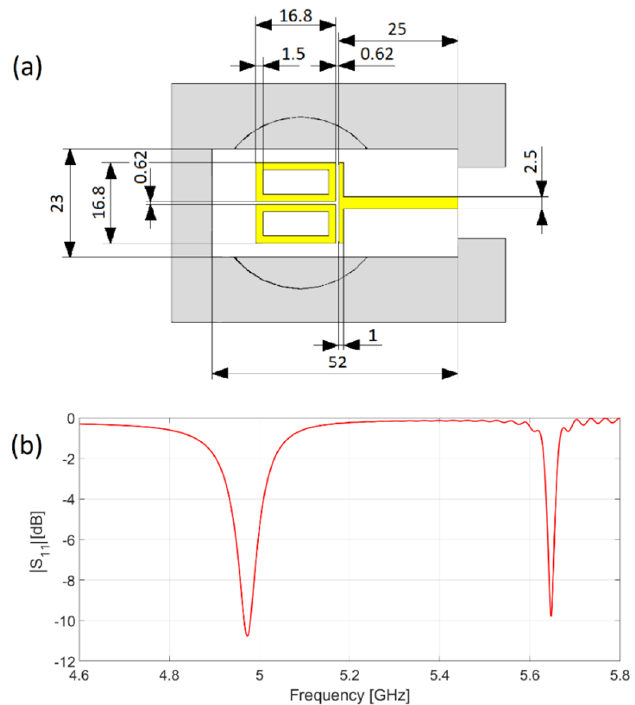
Figure 1. ( a ) Sketch of the top layer of the proposed sensor (all the geometrical parameters are in mm). ( b ) Modulus of the simulated scattering parameter | S 11 | of the sensor in air, supported by the PLA (polylactide) support (grey area) in the frequency range of interest.